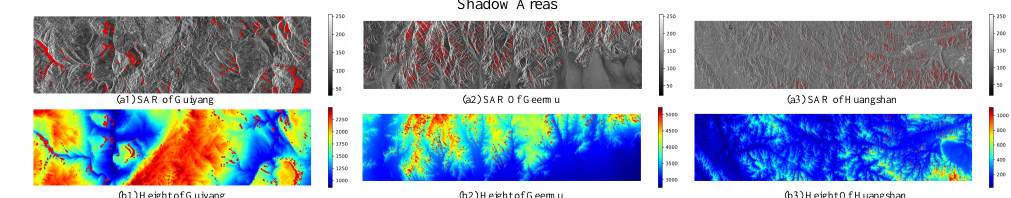
Figure 15. Shadow areas are marked as red points in three